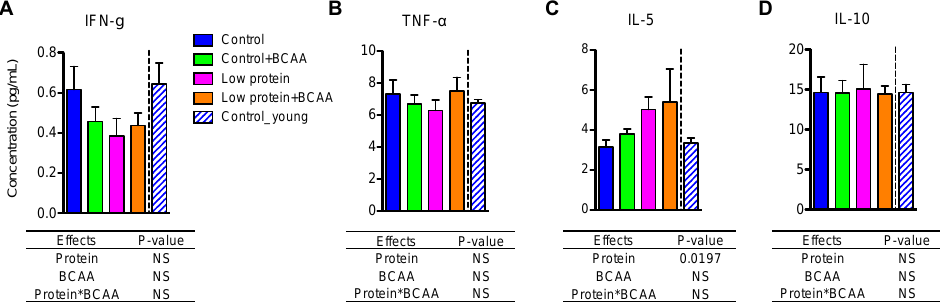
Figure 8. Low protein diet increased circulating IL-5 levels. Plasma pro-inflammatory cytokines IFN- γ ( A ) and TNF- α ( B ), and anti-inflammatory cytokines IL-5 ( C ) and IL-10 ( D ) were determined using multiplex assays. Data represent mean ± SEM ( n = 12 mice/group). Statistical analyses of main effects (protein and BCAA) and interactions (protein*BCAA) are shown below each graph.